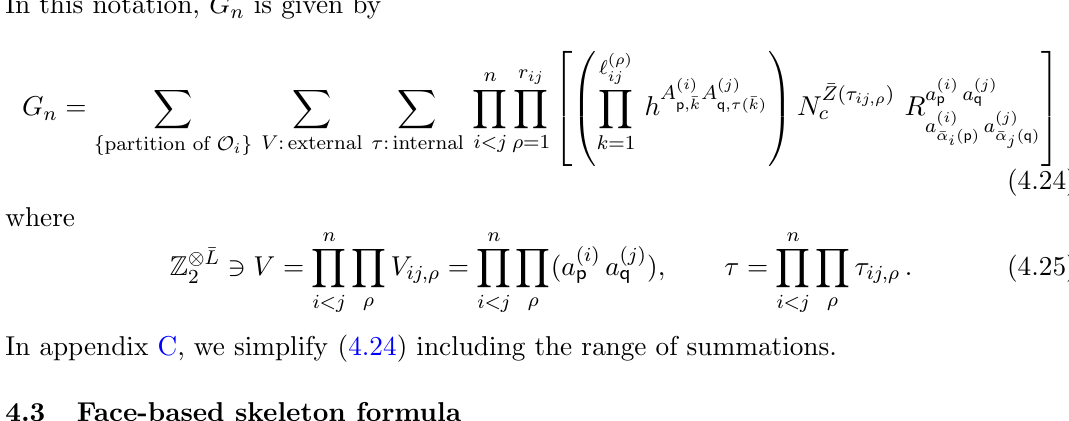
(cid:0) (cid:1) a ; b ; a ; b p q (cid:22) (cid:11) i ( p ) (cid:22) (cid:11) j ( q )